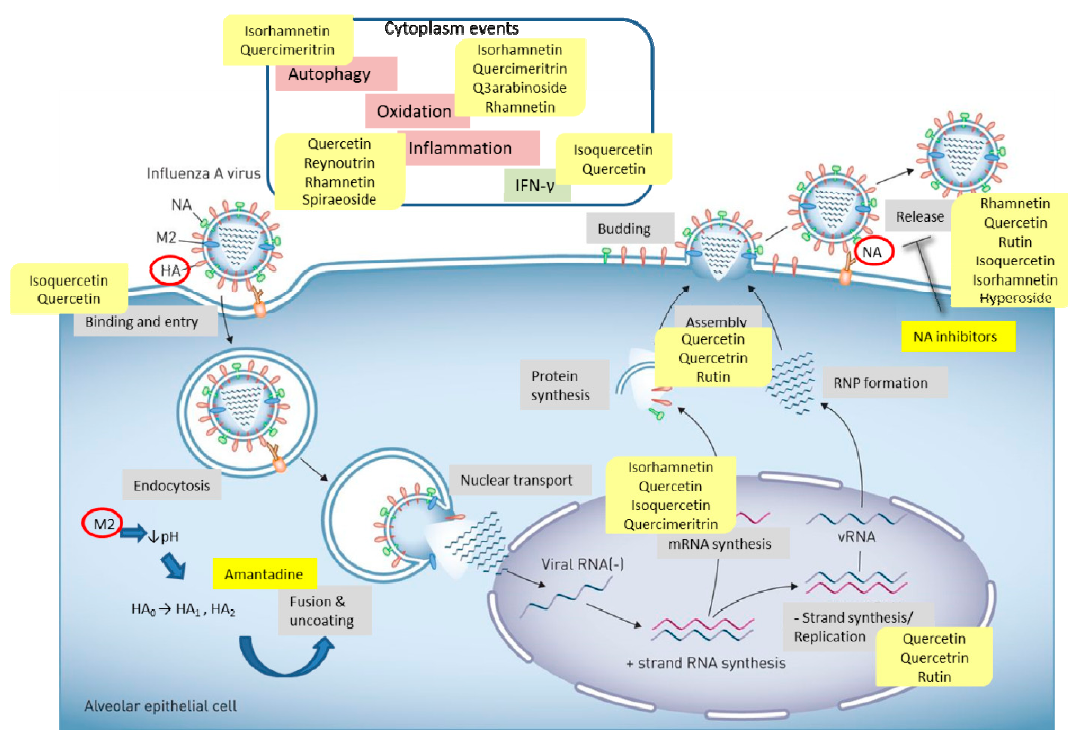
Figure 2. Schematic of the influenza virus life cycle and the pathways affected by quercetin and its derivatives. Influenza virus uses Hemagglutinin (HA) receptor for binding and entry. Membrane 2 (M2) ion channel facilitates fusion and uncoating, and neuraminidase activity (NA) induces the release of progeny virus. Quercetin and its derivatives impact different steps of viral life cycle, such as binding, uncoating, mRNA synthesis, negative-strand synthesis, assembly, and release. They can also affect cytoplasm events to influence the virus indirectly.